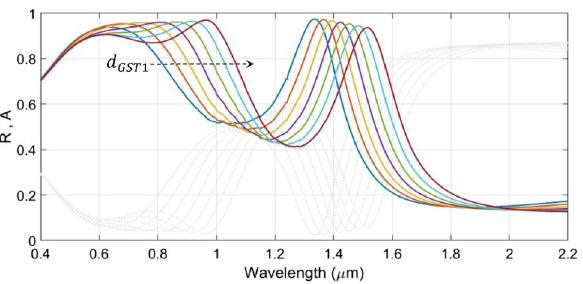
Figure 3. Wavelength dependence of the absorbance A (and reflectance R ) of the structure under fixed d s3 (= 50 nm), and varying d GST1 . Coloured lines correspond to d GST2 (= 90 nm), d s1 (= 100 nm), and d s2 = absorbance; gray dotted lines represent reflectance. The dashed arrow represents increase in d GST1 .